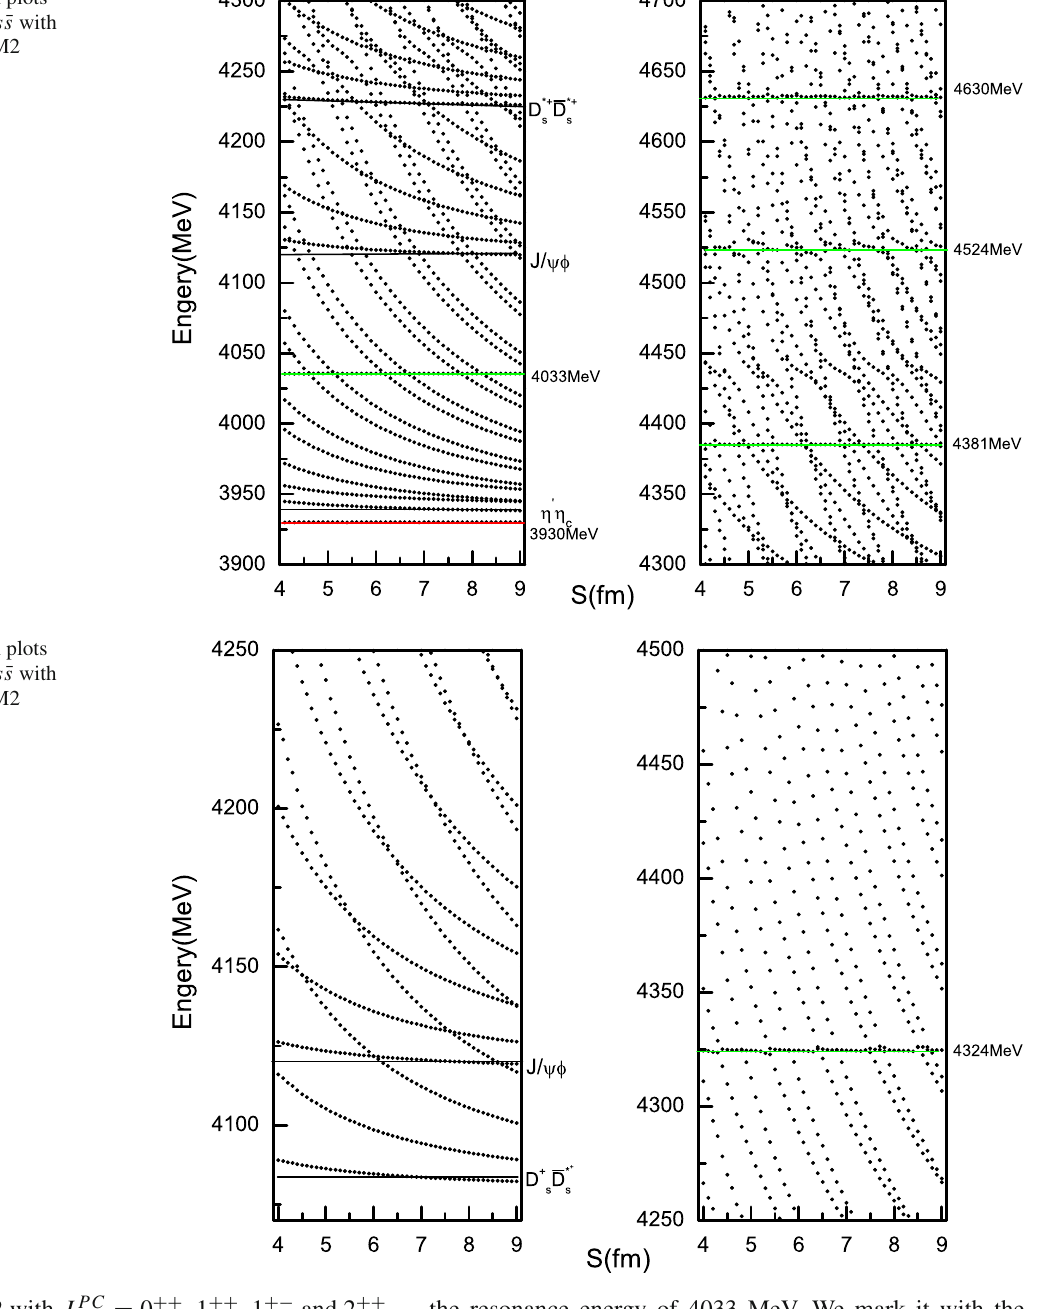
Fig. 2 The stabilization plots of the energies of the c ¯ cs ¯ s with